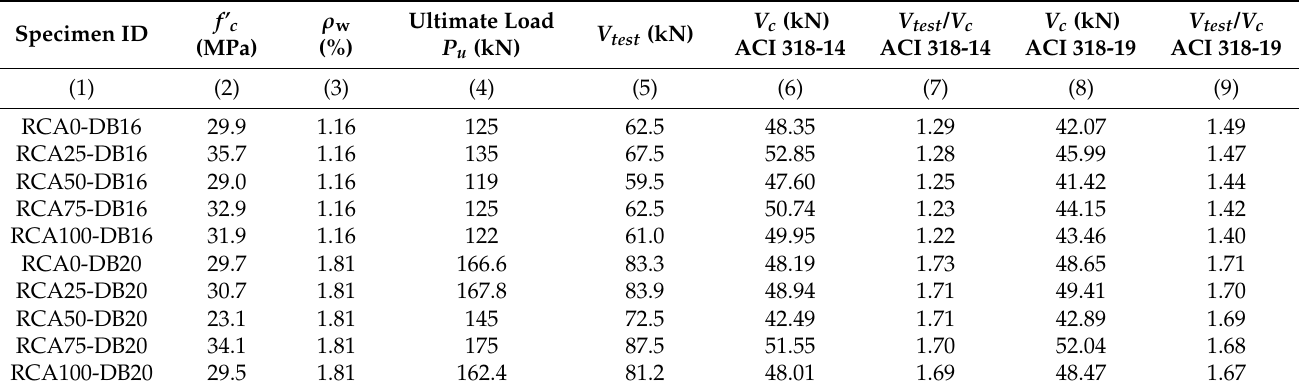
Table 5. Summary of concrete and beam test